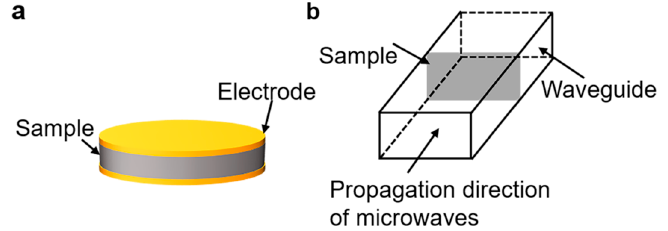
Figure 7. Schematic of ( a ) parallel plate method and ( b ) microwave method.